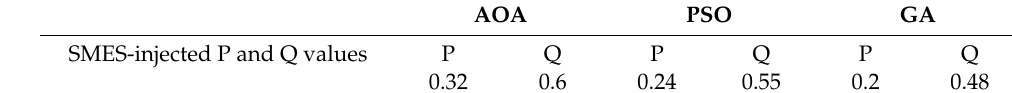
Table 5. SMES-injected active and reactive power for L-L-L-G scenario.